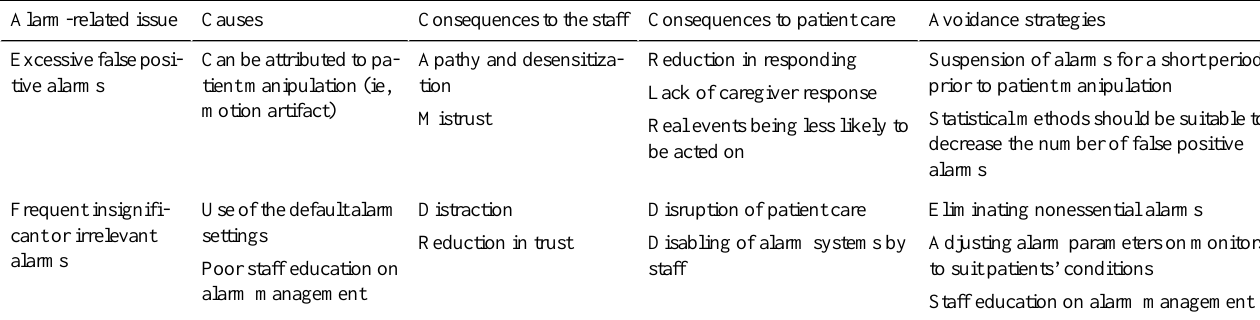
Table 1. Summary of alarm-related